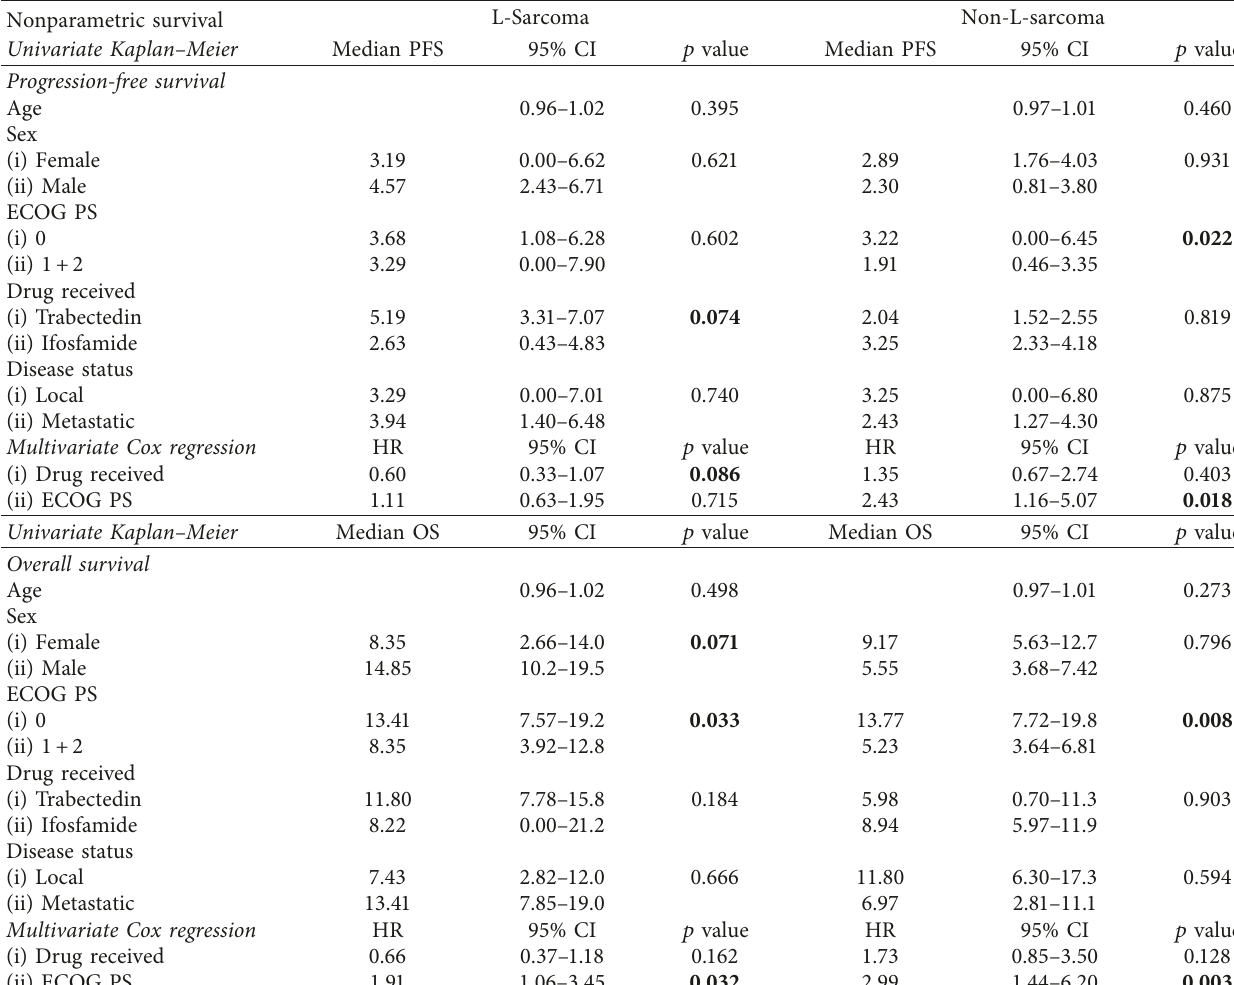
Table 6: Nonparametric analysis of survival for L-sarcoma and non-L-sarcoma patients, univariate Kaplan–Meier analysis with median survival in months and logrank test, and multivariate Cox regression. The univariate hazard ratio for age per year increase was 0.99 for all